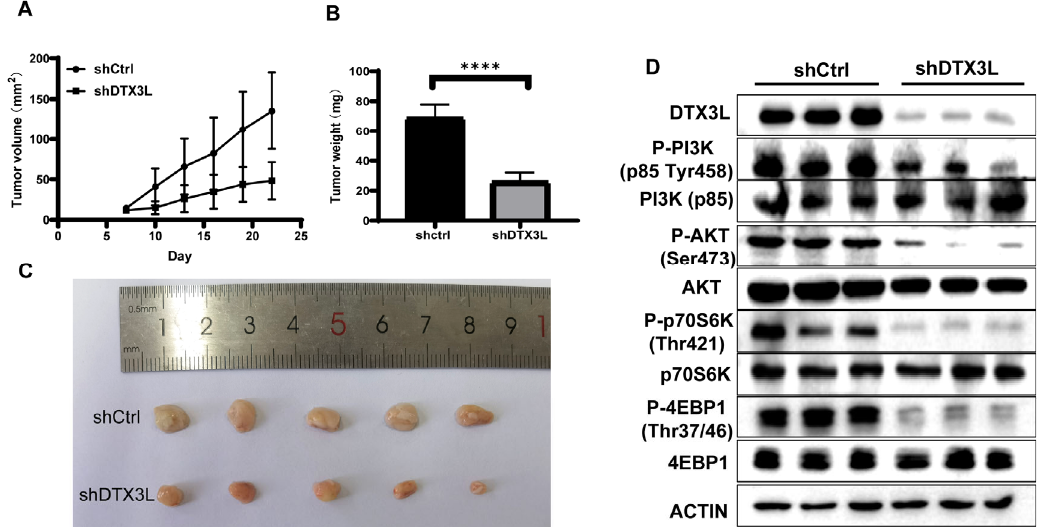
Figure 8. DTX3L knockdown inhibited tumorigenesis in a nude mouse xenograft model. ( A ) Tumor volume was calculated every three days. ( B ) Tumor weight of xenografts on day 22 post-inoculation. ( C ) Representative photographs of the tumors. ( D ) Level of DTX3L and PI3K/AKT/mTOR signaling pathways of representative tumor tissues subjected to Western blot analysis, **** p < 0.0001.